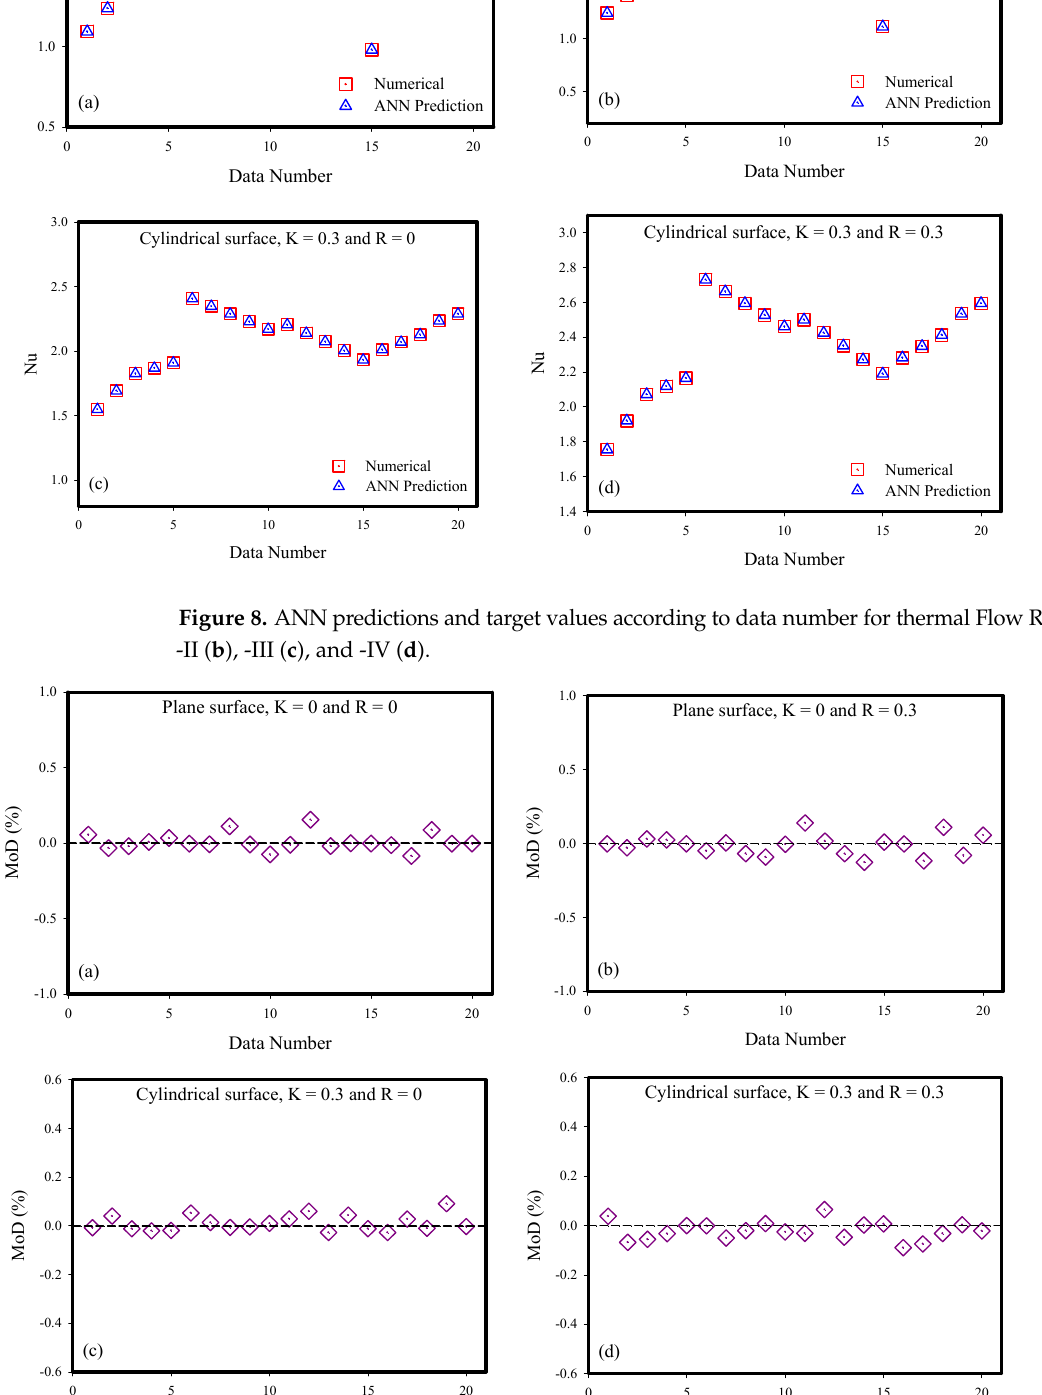
Figure 8. ANN predictions and target values according to data number for thermal Flow Regimes- -I ( a ), -II ( b ), -III ( c ), and -IV ( d ).